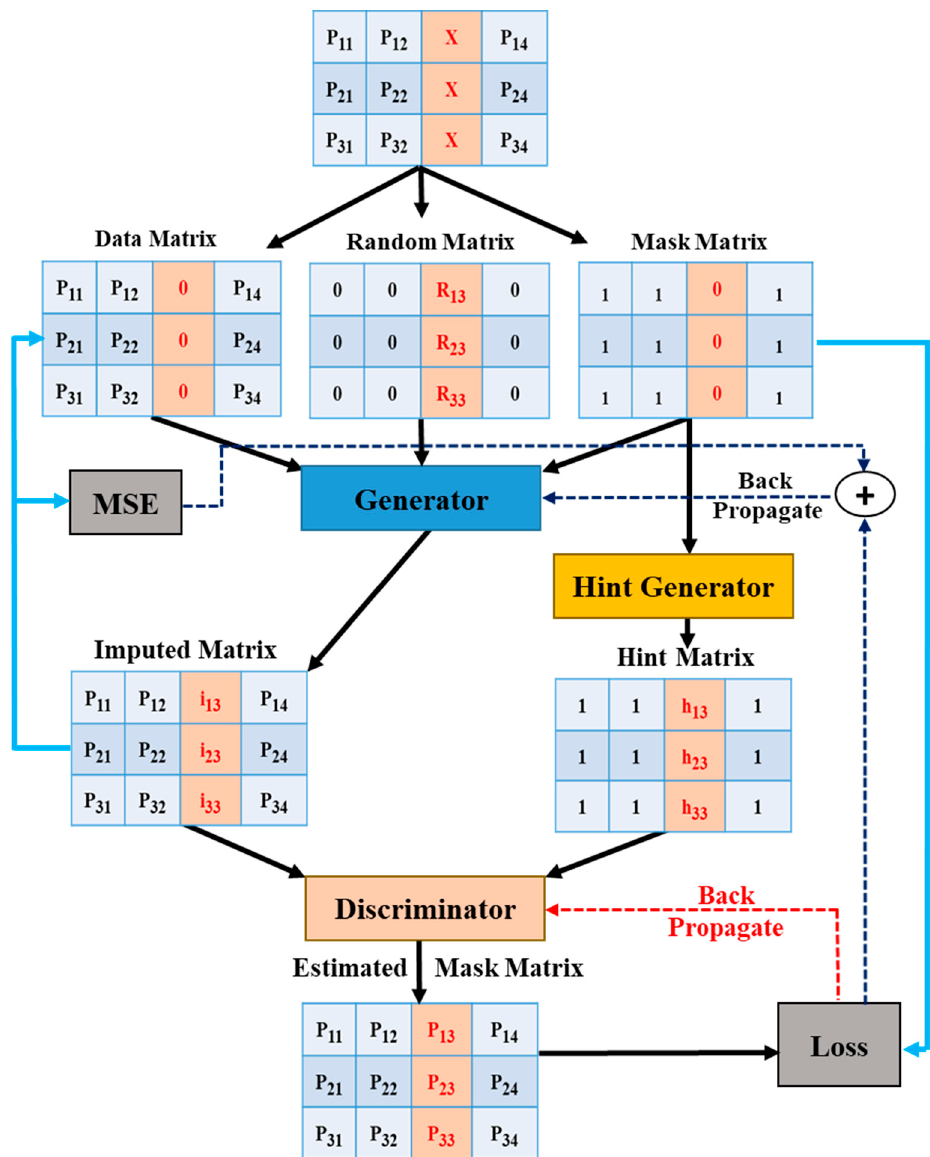
Figure 5. Operation of generative adversarial imputation network (GAIN).